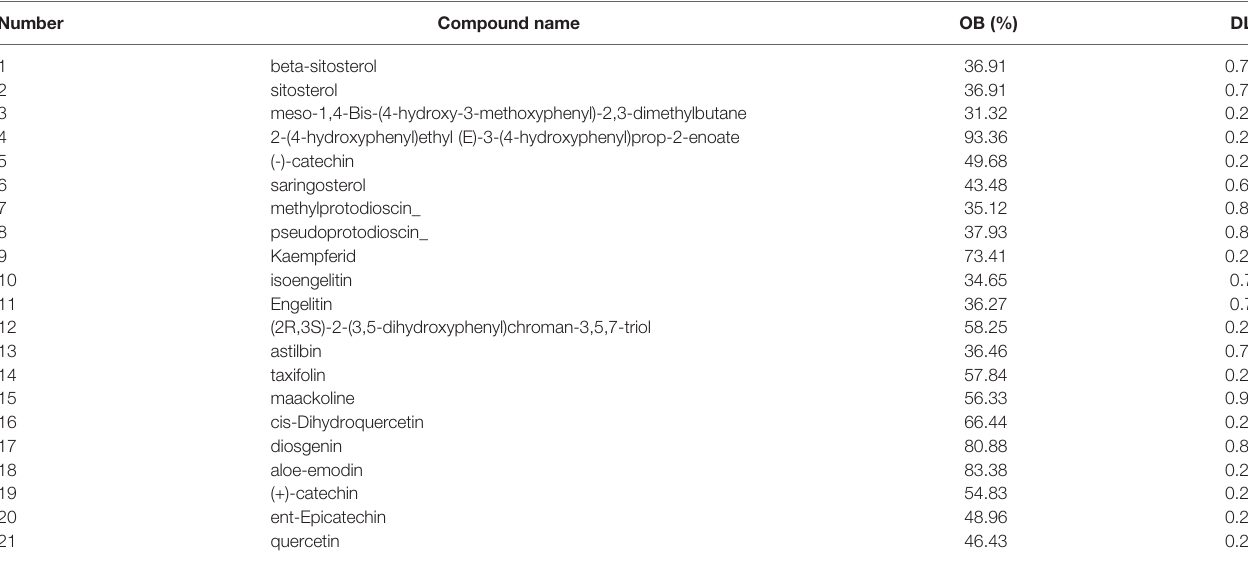
TABLE 1 | Active components list of Siteng